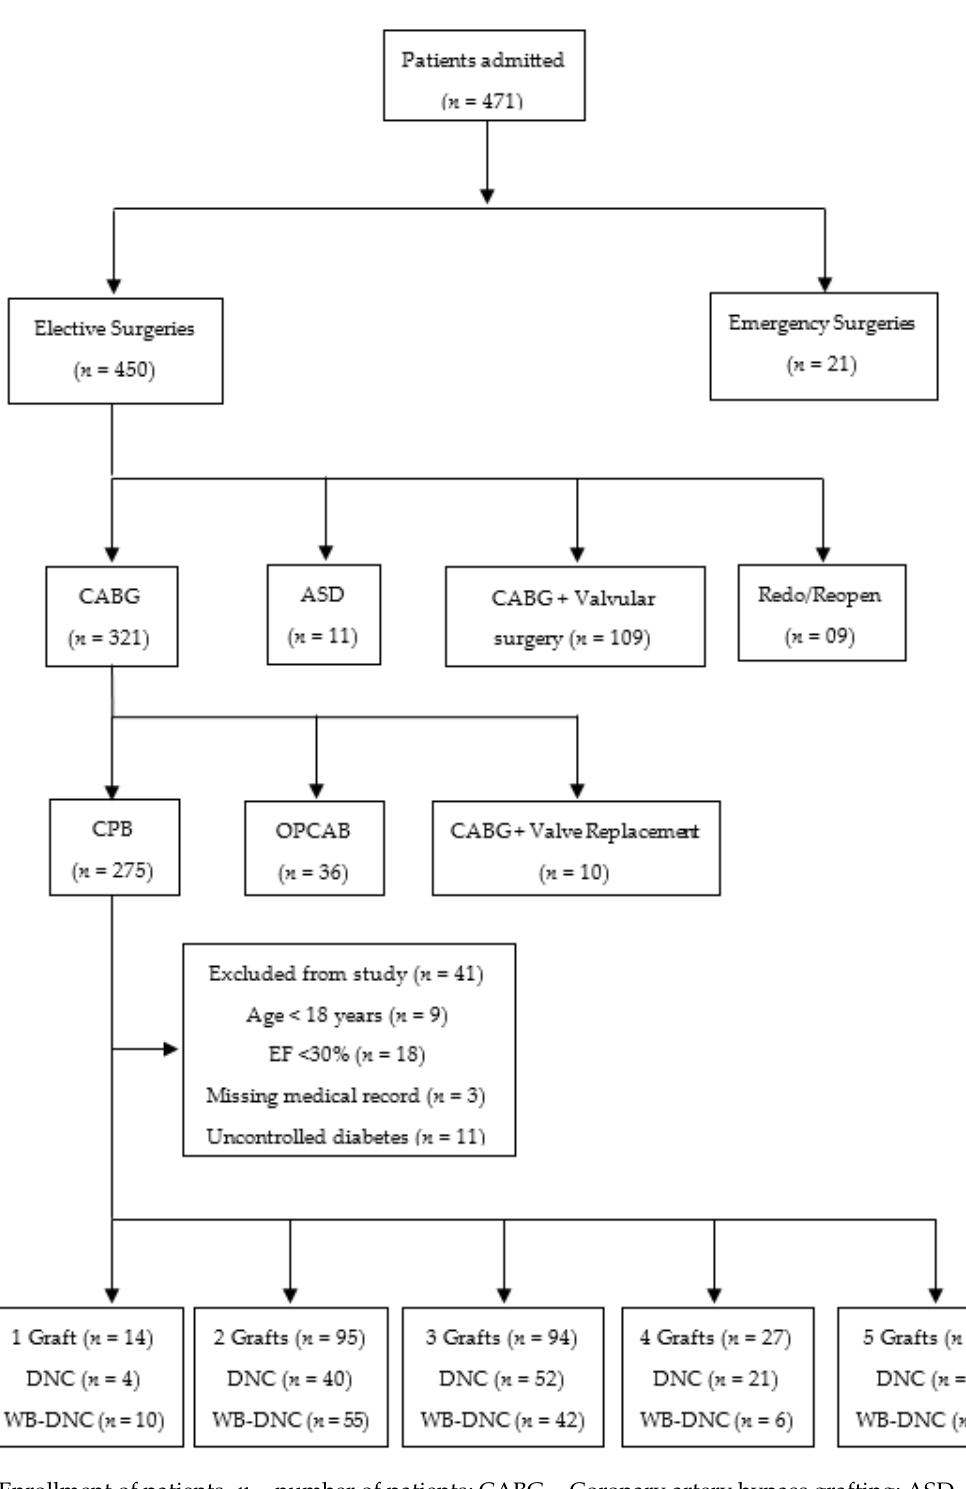
Figure 1. Enrollment of patients. n = number of patients; CABG = Coronary artery bypass grafting; ASD = Atrial septal defect; CPB = Cardiopulmonary bypass; OPCAB = Off-pump coronary artery bypass; EF = Ejection fraction.